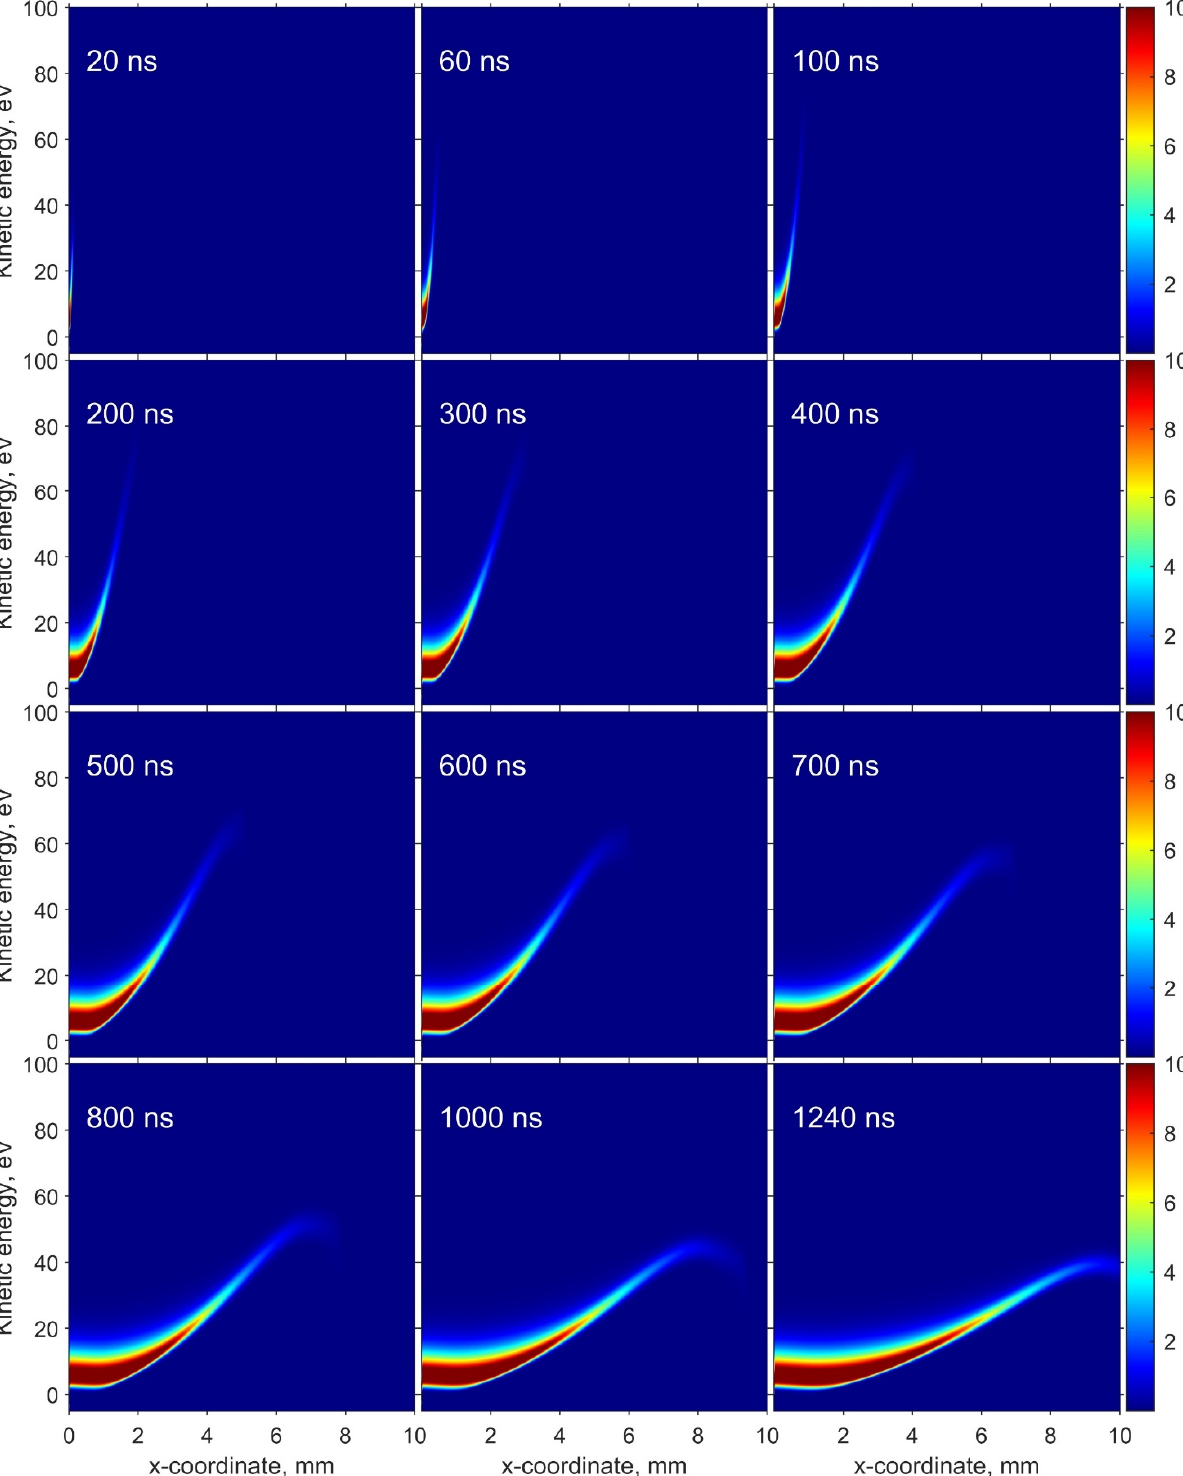
Figure 1. Density plots of the ion (Sb + ) distribution function given at selected time steps for the vacuum breakdown simulation in a diode with antimony cathode. The scale is linear in 10 39 s/(kg m 4 ) units.